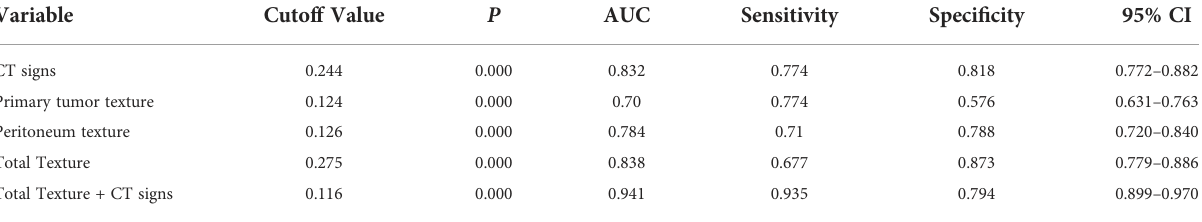
TABLE 4 ROC curves parameters of different